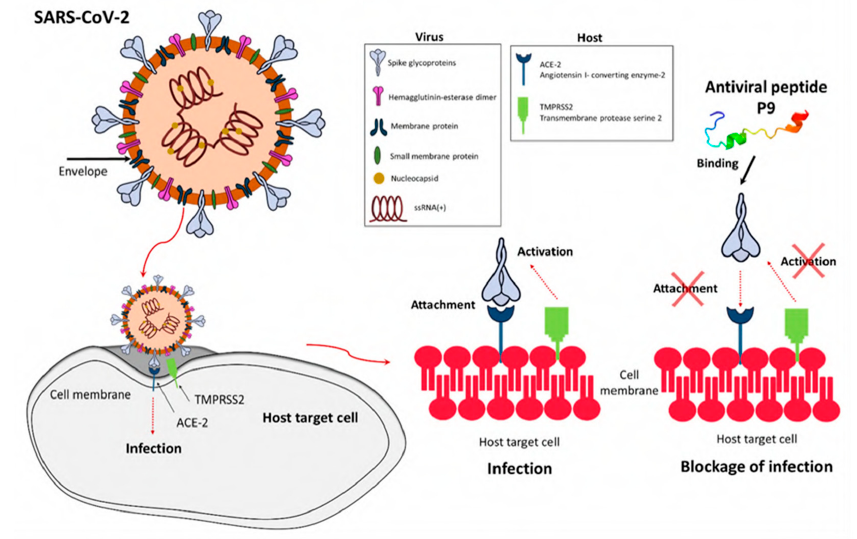
Figure 9. Antiviral peptide P9, derived from mouse β ‐ defensin, prevents SARS ‐ CoV ‐ 2 infection by attaching to viral glycoprotein and masking ACE2 receptor on host cells (reprinted with permission from Tonk et al., 2021 [103]).